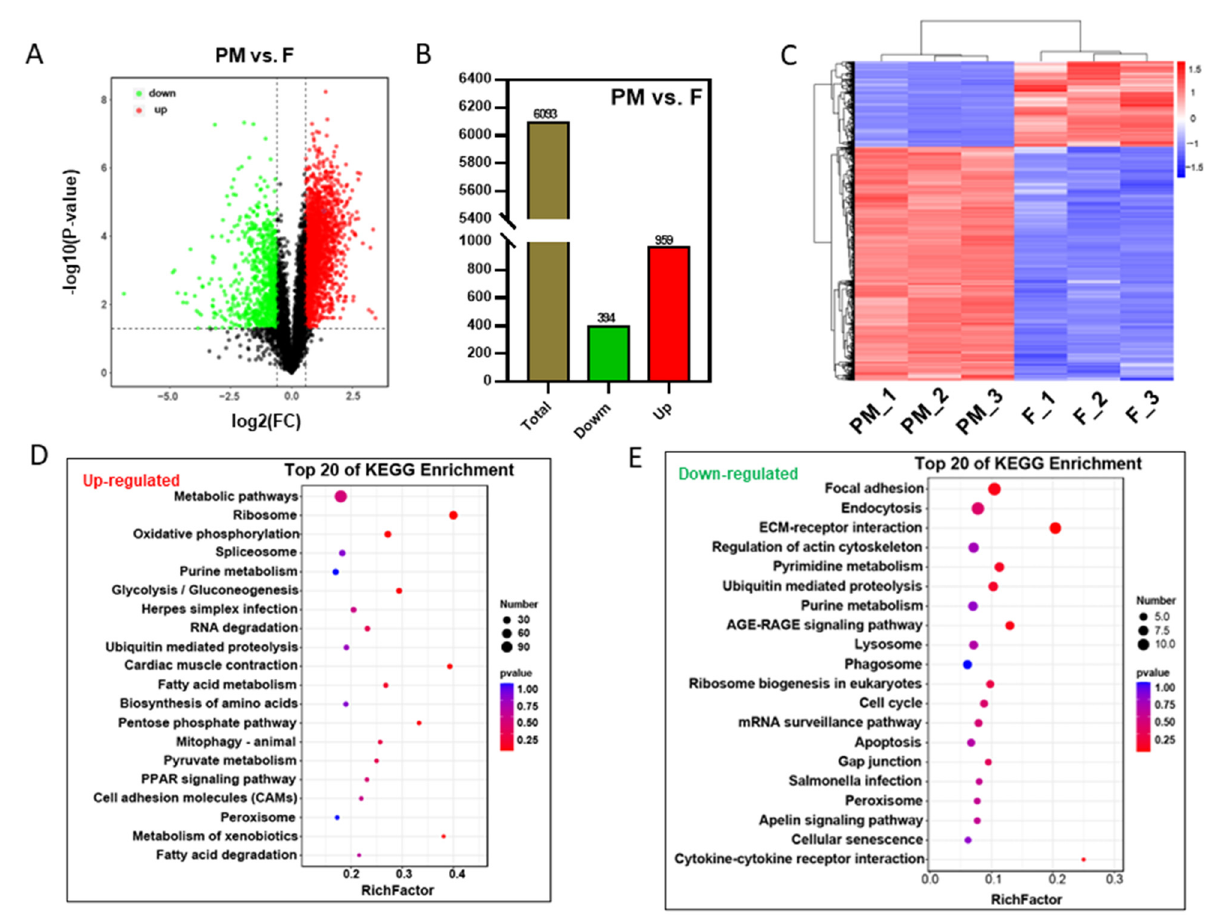
Figure 4. Analysis of differentially abundant proteins between females and pseudo-males. ( A ) The differentially abundant proteins between pseudo-males and females. ( B ) The number of differen- tially abundant proteins between pseudo-males and females. ( C ) Cluster analysis of differentially abundant proteins between pseudo-males and females. ( D ) Top 20 enriched signaling pathways of upregulated proteins between pseudo-males and females. ( E ) Top 20 enriched signaling pathways of downregulated proteins between pseudo-males and females.